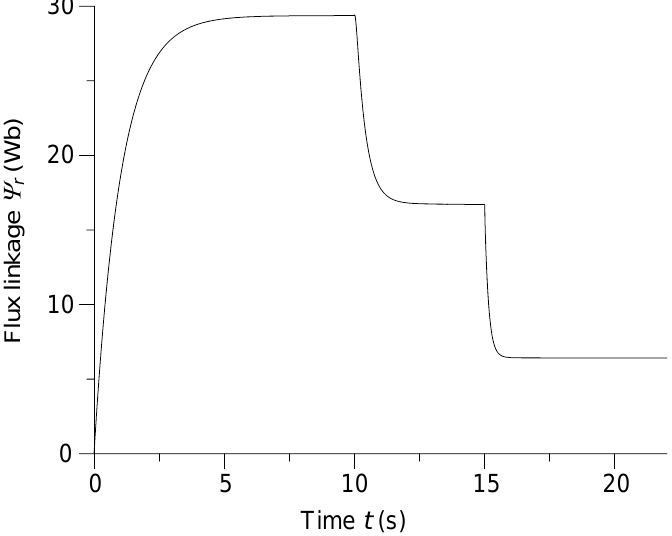
Figure 9. The instantaneous flux linkage for the excitation winding of the shaft generator. From a scientific point of view, based on the interpretation of the time courses pre- sented in Figures 8 and 9, it is possible to determine the nature and time courses of the electromotive forces induced in the armature and rotor windings, because the time deriva- tives of the analyzed flux linkages according to Faraday’s law represents the induced electromotive forces, i.e., the main energy sources of the shaft generator. Figure 10 show the instantaneous moments of torsion in the centers of the second and fourth parts of the long drive